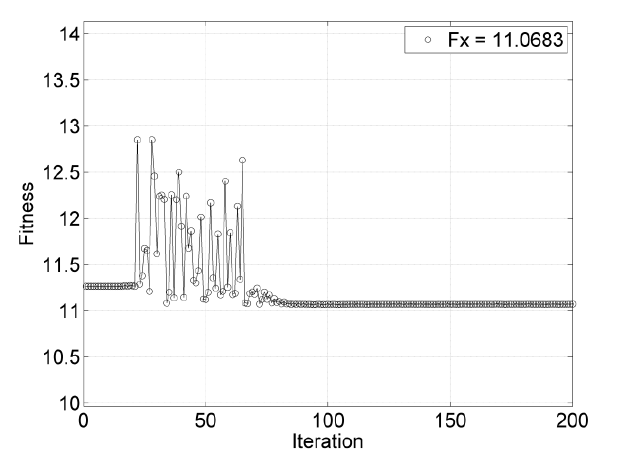
Fig. 12. Hybrid GA fitness evolution.